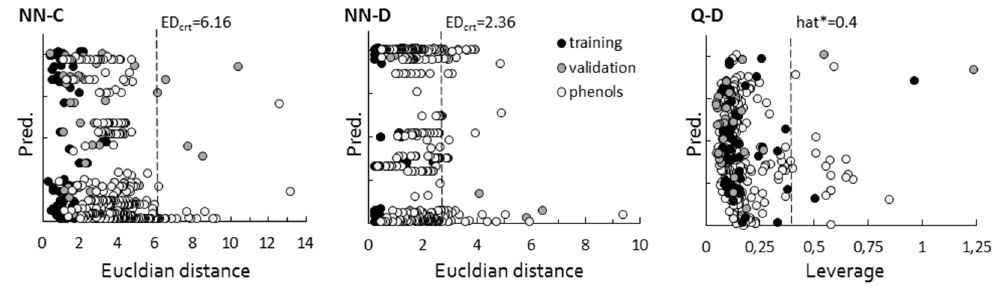
Figure 4. Graphical assessment of the applicability domains of the best three classification models (NN-C, NN-D, Q-D). Compounds with estimated Euclidian distances/leverages > ED crit /hat* fail out of applicability domain of model.